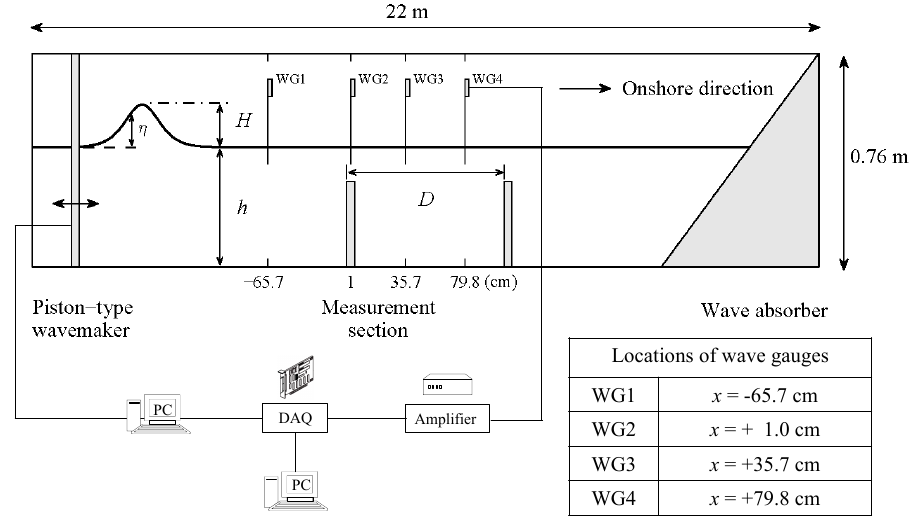
Figure 1. Overview of experimental set-up, facilities (not to scale) and definitions of variable assigned for a dual-solid-barrier configuration.